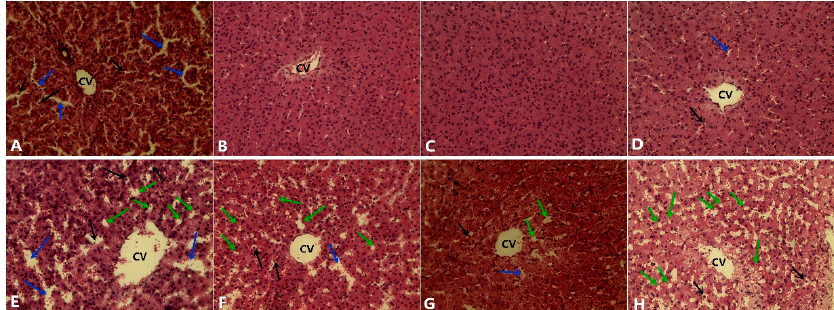
Figure 1. Hematoxylin and eosin-stained liver slices from the treated pig. ( A ) Pigs fed a normal diet with 0 mg/kg Se; ( B ) pigs fed a normal diet with 0.3 mg/kg Se; ( C ) pigs fed a normal diet with 1.0 mg/kg Se; ( D ) pigs fed a normal diet with 3.0 mg/kg Se; ( E ) pigs fed a high-fat diet with 0 mg/kg Se; ( F ) pigs fed a high-fat diet with 0.3 mg/kg Se; ( G ) pigs fed a high-fat diet with 1.0 mg/kg Se; ( H ) pigs fed a high-fat diet with 3.0 mg/kg Se. The blue arrow indicates the sinusoids enlarged between the plates of the hepatocytes. The black arrows indicate hepatic cell necrosis. The green arrow indicates a micro- and macrovesicular fatty change. CV: central vein. (H.E. × 400).